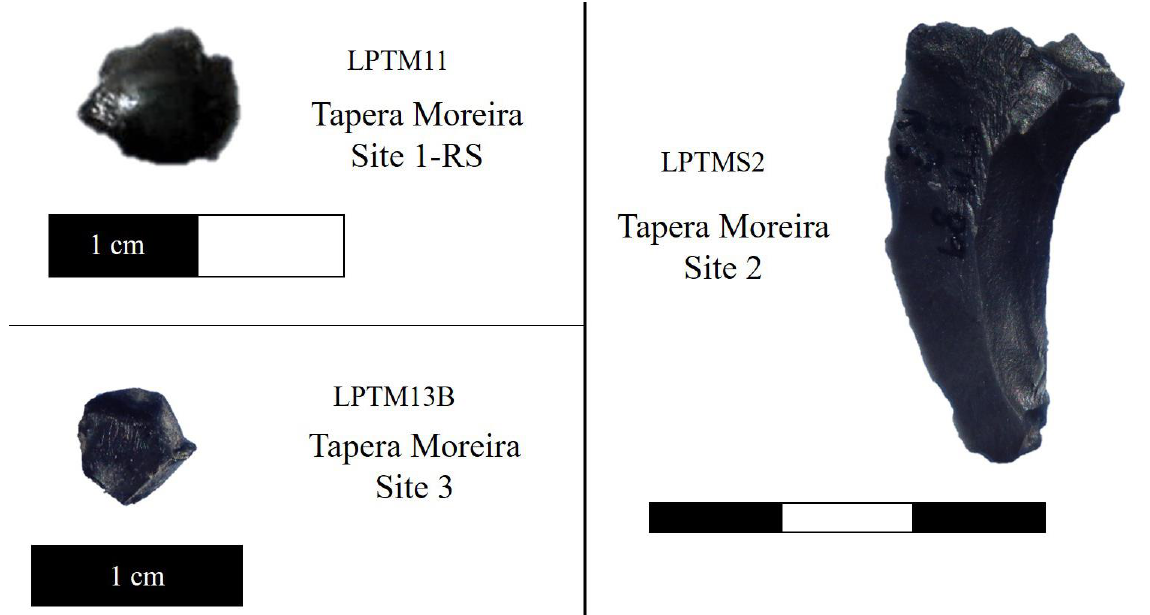
Figure 7. Obsidian artefacts from Tapera Moreira archaeological locality - Sites 1, 2 and 3. Scale bars are composed of 1 cm